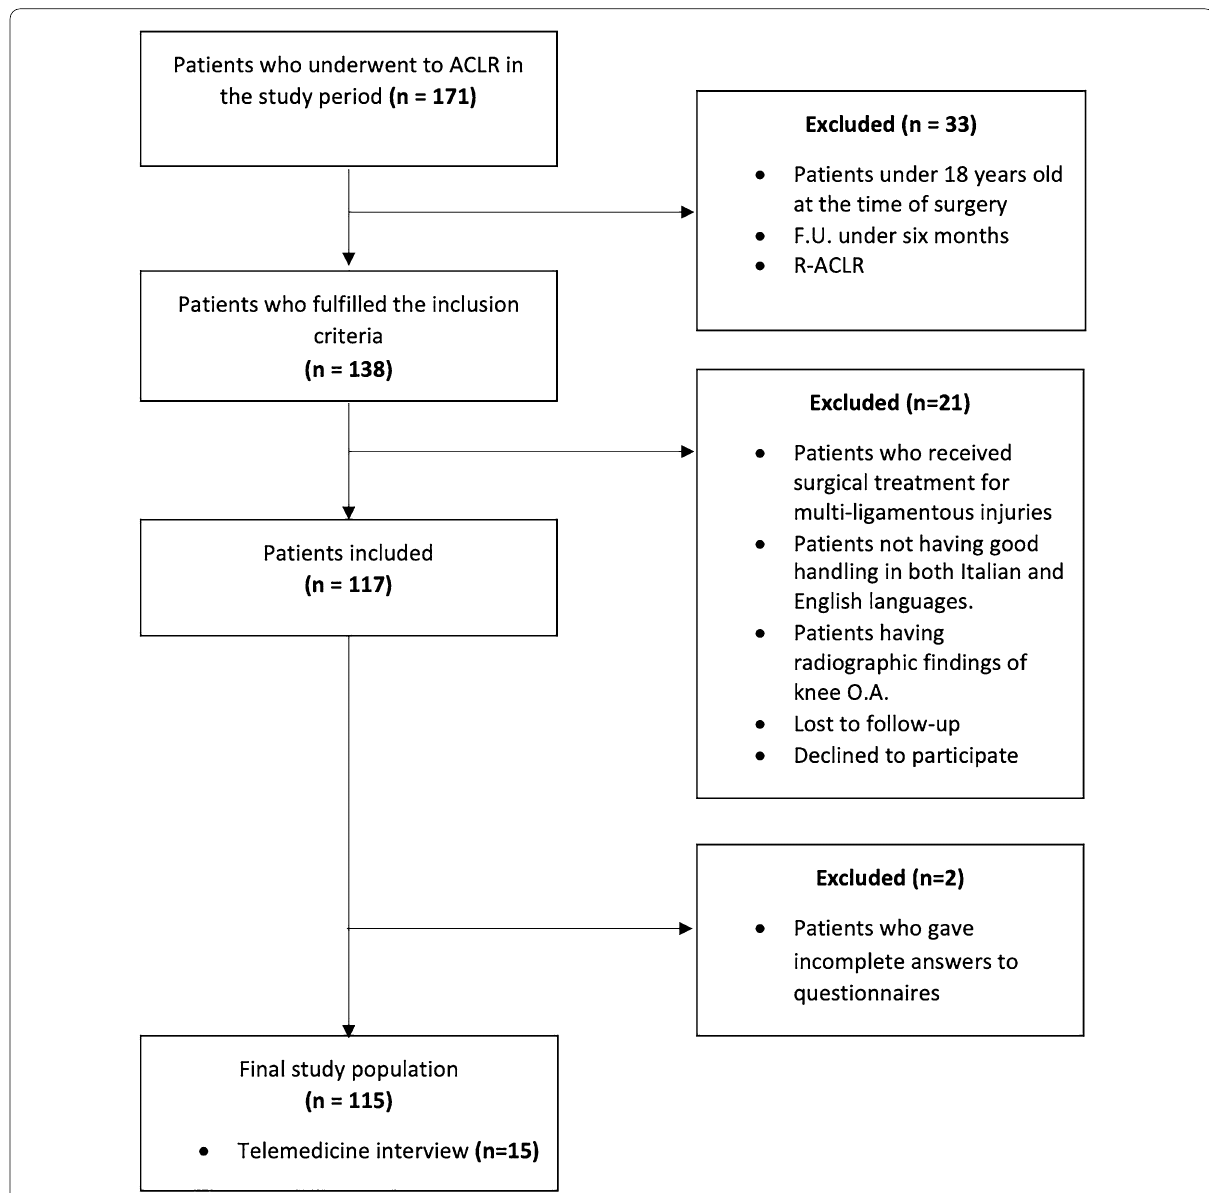
Fig. 1 Flowchart of the study, created in line with the Strengthening the Reporting of Observational Studies in Epidemiology (STROBE) statement (http:// www. strob estat ement. org). ACLR anterior cruciate ligament reconstruction, F.U. follow‑up, O.A. osteoarthritis, R-ACLR revision anterior